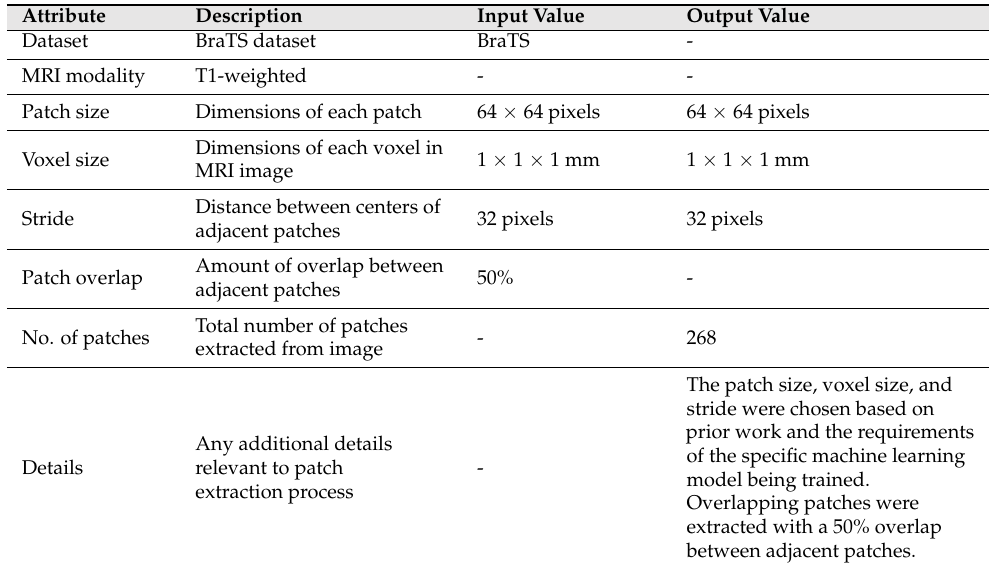
Table 4. Attributes of the BraTS dataset with description, input and output value. Attribute